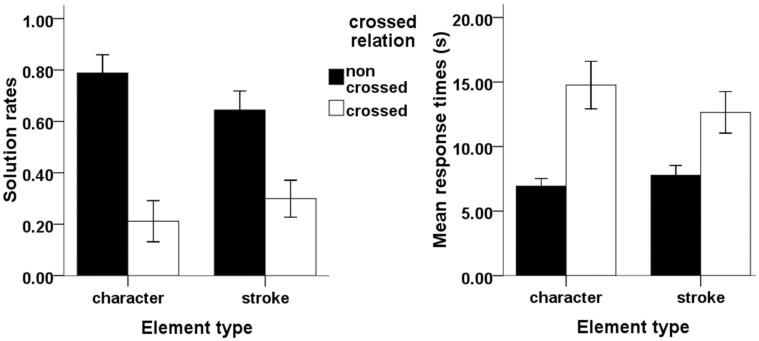
Illustration of element type effect and crossed relation effect on solution rates (left) and mean response times (RTs) (right). Error bars denote 95% Confidence Interval.